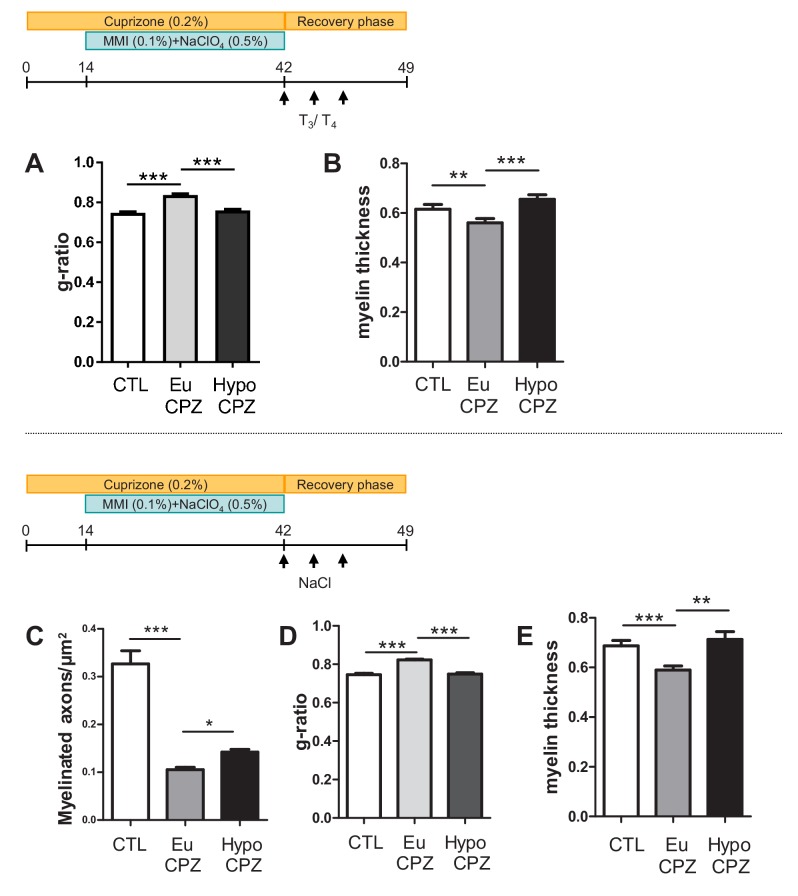
(A–B) Mice received T3/T4 pulses during the recuperation phase.(A) Quantification of the g-ratio in control (CTL), euthyroid-CPZ (EuCPZ) and hypothyroid-CPZ (HypoCPZ) (mean ± SEM, n > 100 per group. ***p<0.001, Kruskal-Wallis test followed by a Dunn’s post-hoc test). (B) Quantification of myelin thickness of the myelin sheath in hypothyroid-CPZ (HypoCPZ) conditions shows thickness is restored to control levels compared to euthyroid-CPZ condition (EuCPZ). (mean ± SEM, n > 100 per group. ***p<0.001, **p<0.001, Kruskal-Wallis test followed by a Dunn’s post-hoc test). (C–E) Mice received NaCl during the recuperation phase. (C) Density of remyelinated axons per area (µm2) in CTL, EuCPZ and HypoCPZ after CPZ-induced demyelination. (mean ± SEM, n = 10–12 sections from 2 CTL, 2 EuCPZ and 2 HypoCPZ mice, ***, p<0.0001, Kruskal-Wallis test) (D) Quantification of the g-ratio in CTL, Eu CPZ and HypoCPZ mice (mean ± SEM, n > 100 per group. ***p<0.001, Kruskal-Wallis test followed by a Dunn’s post-hoc test). (E) Quantification of the myelin sheaththickness in CTL, EuCPZ and HypoCPZ mice (mean ± SEM, n > 100 per group. ***p<0.001, **p<0.001, Kruskal-Wallis test followed by Dunn’s post-hoc test).